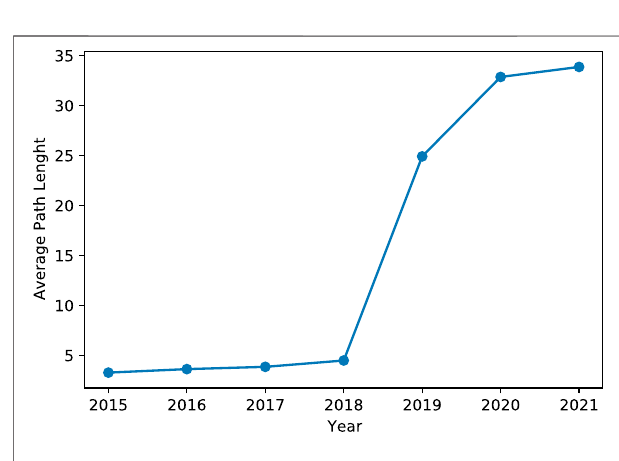
FIGURE 4 | Average Path Length over